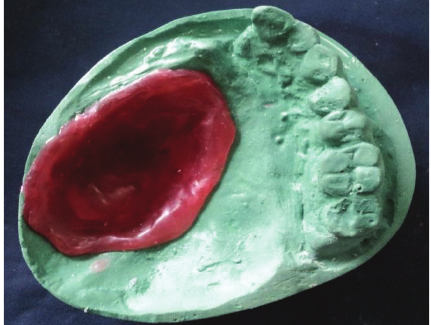
Figure 1: Intraoral defect.